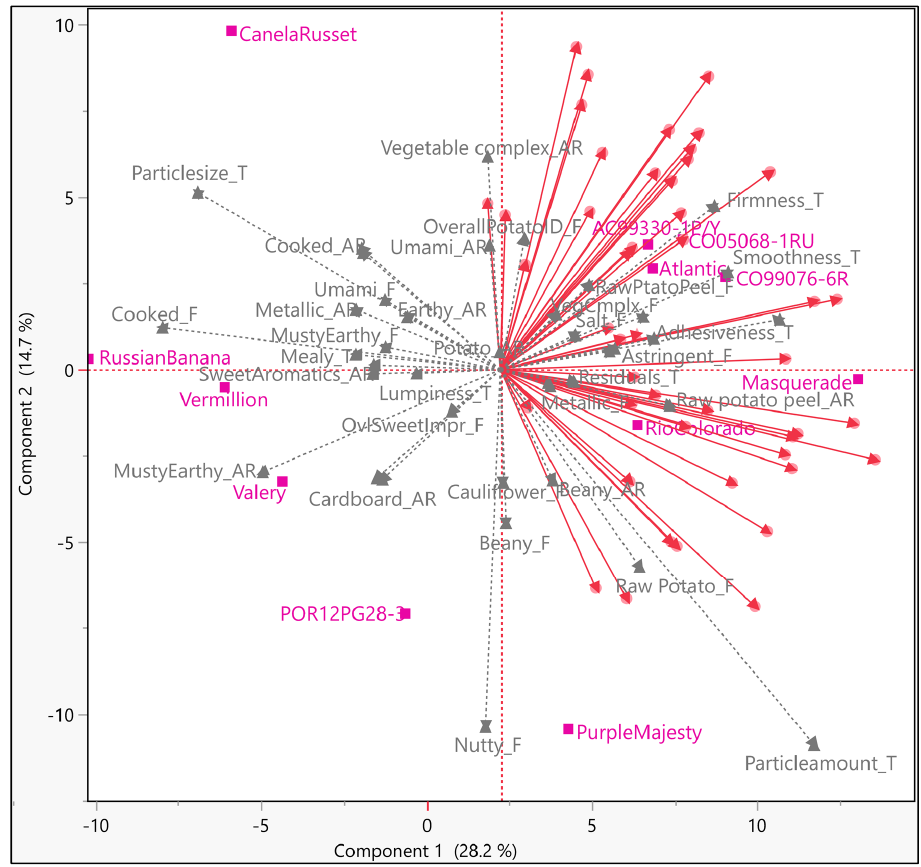
Figure 2. Internal Preference Mapping (IPM) plot for the first segment of respondents ( N = 46); Magenta colored markers ■ and labels—Samples; gray colored markers ▲ and labels—sensory descriptors; red colored markers ● and vectors—participants/consumers. IPM plots were obtained by using PCA technique on covariance. All sensory descriptors were added as supplementary variables. Homogeneous respondents were pre-identified by using Hierarchical clustering.